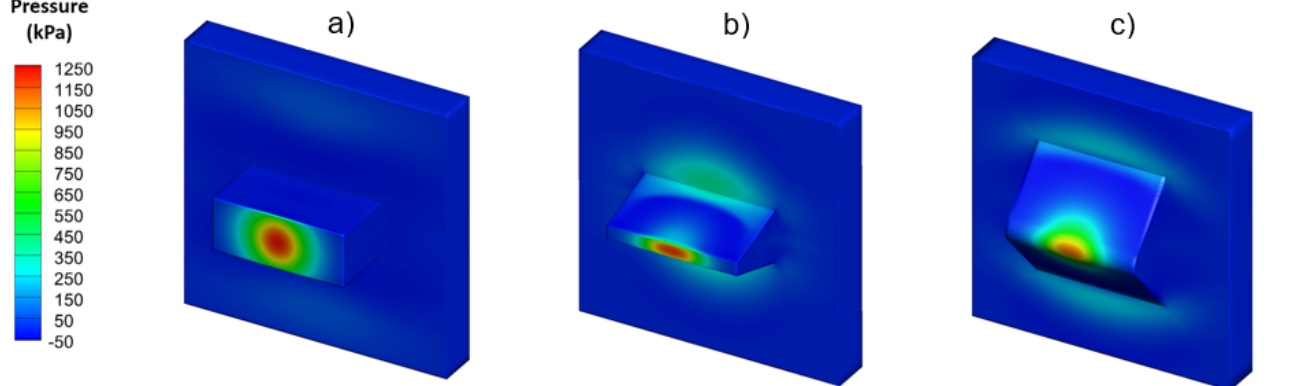
Figure 7. Pressure distribution on the surface of the ( a ) vertical, ( b ) inclined, and ( c ) the smooth walls.